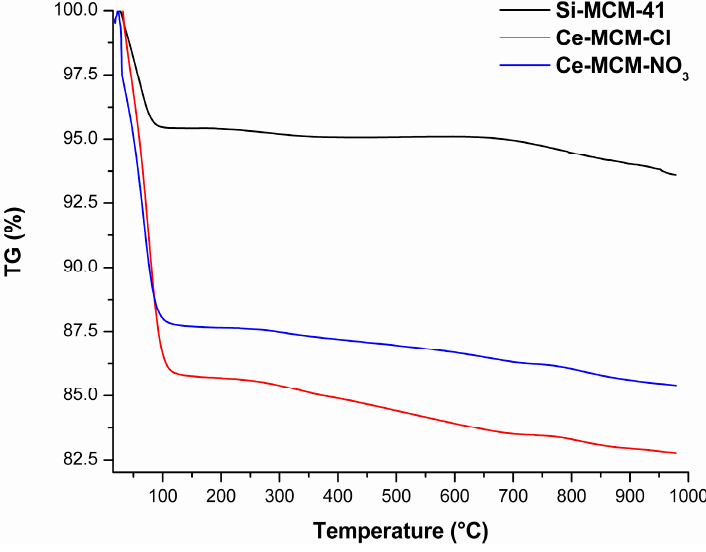
Figure 14. TG curves for the calcined MCM-41 materials.